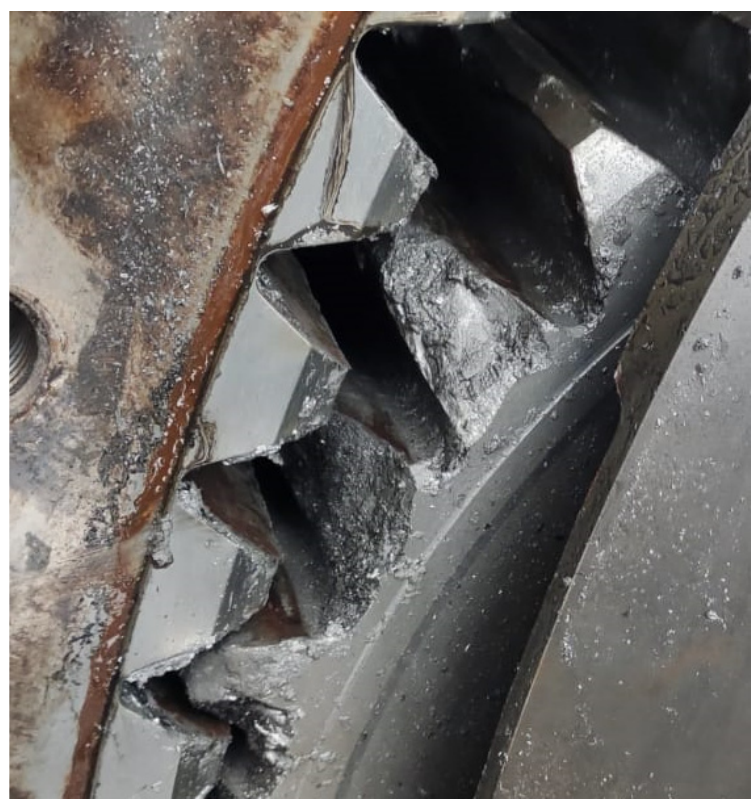
Figure 10. Broken off fragment of a planet wheel tooth in the planetary gear.